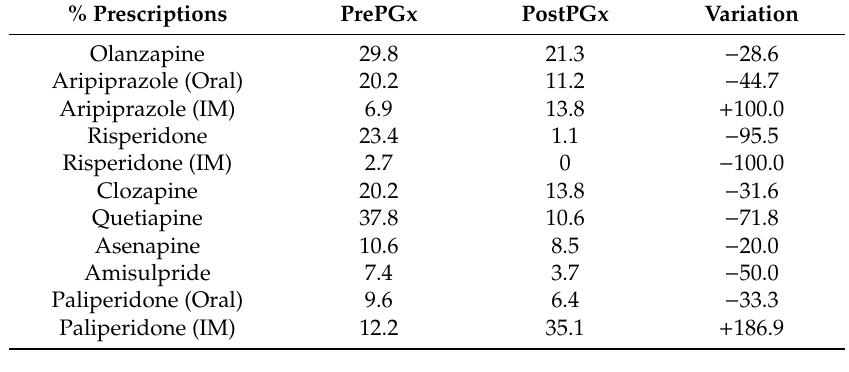
Table 10. % of prescriptions of the di ff erent antipsychotics and presentations.